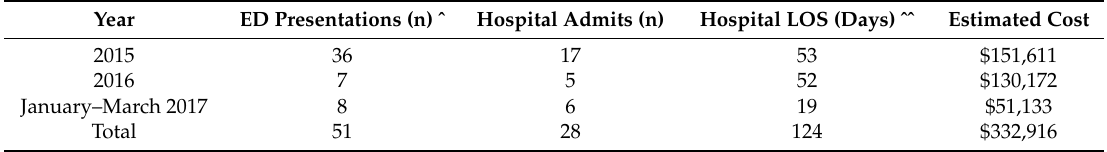
Table 1. Case 1: Hospital presentations and admissions (January 2015–March